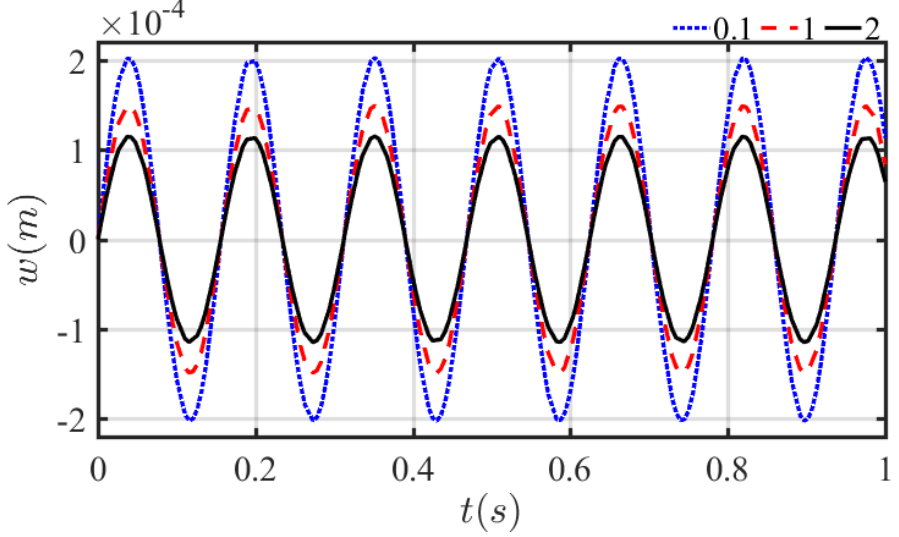
9 of 16 Figure 5. Effect of GPL distributions on the nonlinear transient vibrations of fluid ‐ conveying pipes. The parameters of blast load are one of the most important factors in an analysis of nonlinear transient dynamics. Given 300.6 K T 